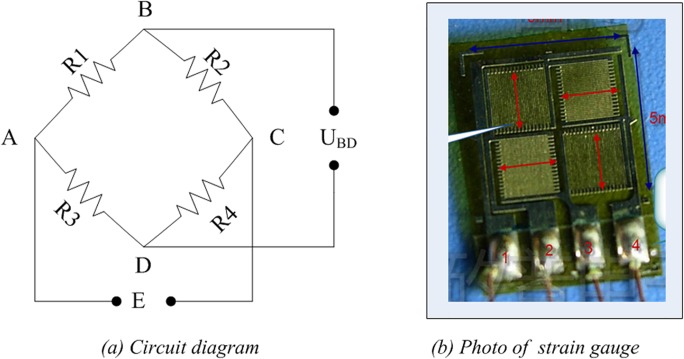
Circuit diagram and photo of each strain gauge.